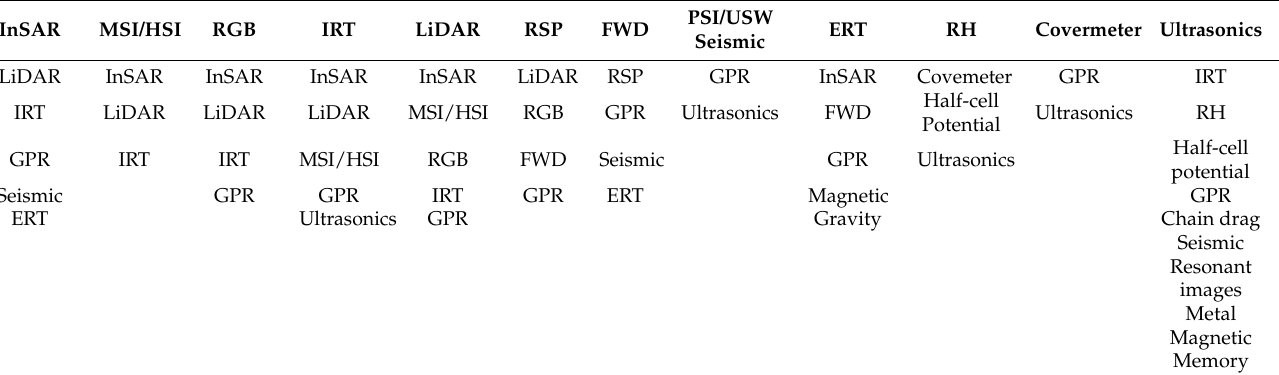
Table 3. Most interesting NDT combinations for the assessment of both flexible and rigid